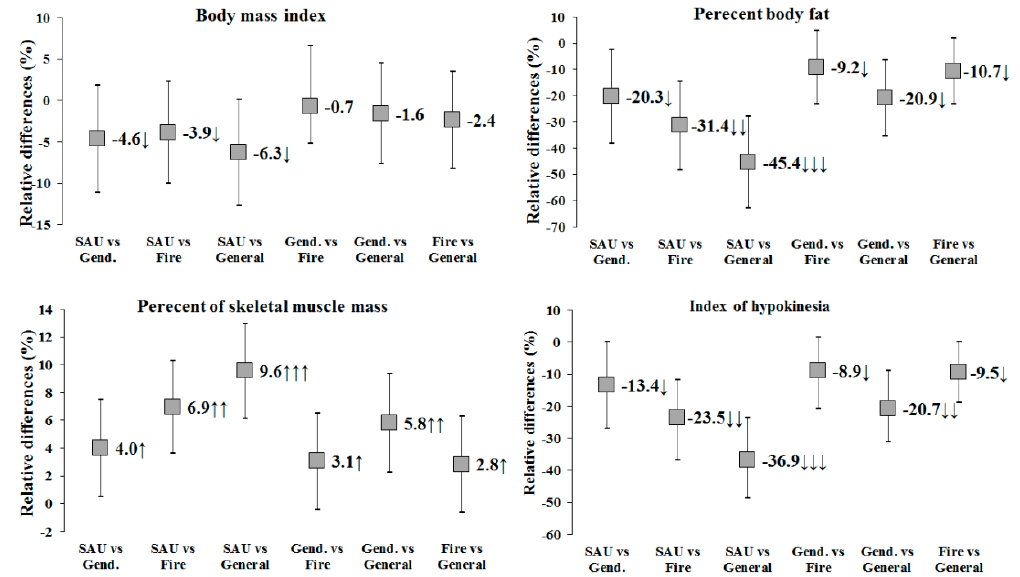
Figure1. Relative(%)between-occupationdi ff erencesandmagnitudeofdi ff erences. Small( ↓ ), moderate Figure 1. Relative (%) between-occupation differences and magnitude of differences. Small ( ↓ ), ( ↓↓ ) and large ( ↓↓↓ ) negative di ff erence. Small ( ↑ ), moderate ( ↑↑ ), and large ( ↑↑↑ ) positive di ff moderate ( ↓↓ ) and large ( ↓↓↓ ) negative difference. Small ( ↑ ), moderate ( ↑↑ ), and large ( ↑↑↑ ) positive difference.